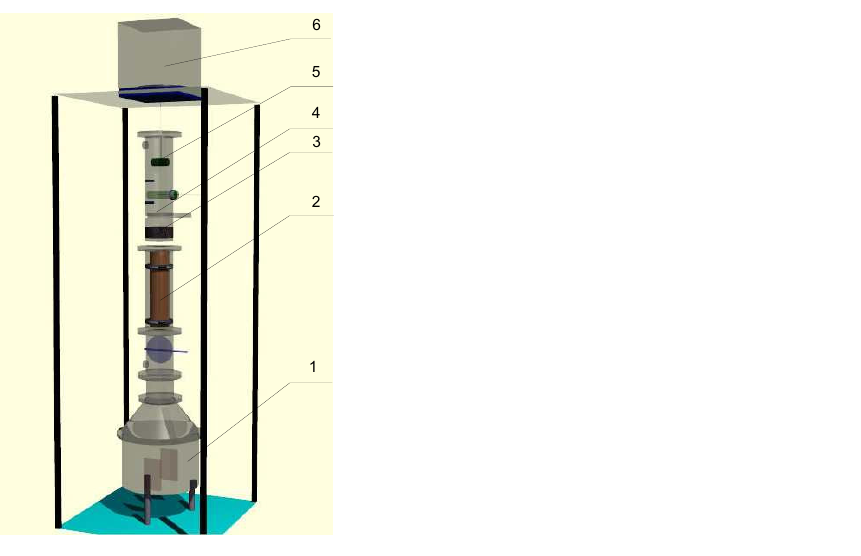
Figure 3. Sorption isobars for cut tobacco lamina (x) and stem (o). Again, sorption isobars may be approximated by a selected empirical equation. However, one may consider replotting Figure 3 as a w = f(X) , defining a w by the following equation. )( 0 tpP a sw = (6) The curve obtained is shown in Figure 4 for lamina only.